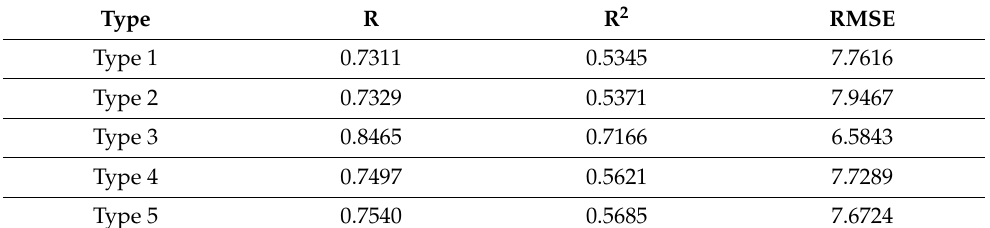
Table 10. Regression analysis results of three-dimensional equations for predicting the ultimate compressive strength of the SMA-confined concrete cylindrical specimens.